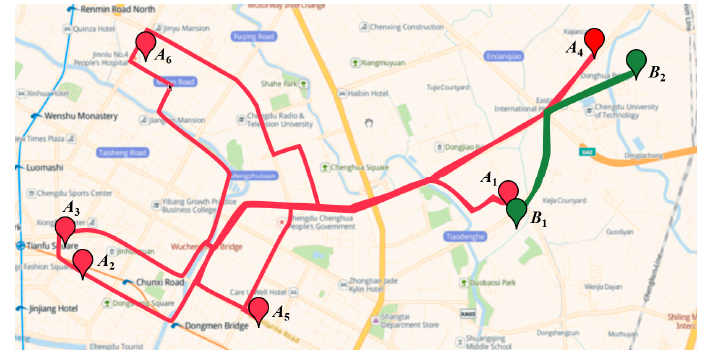
Figure 1. Moving trajectories of different users.